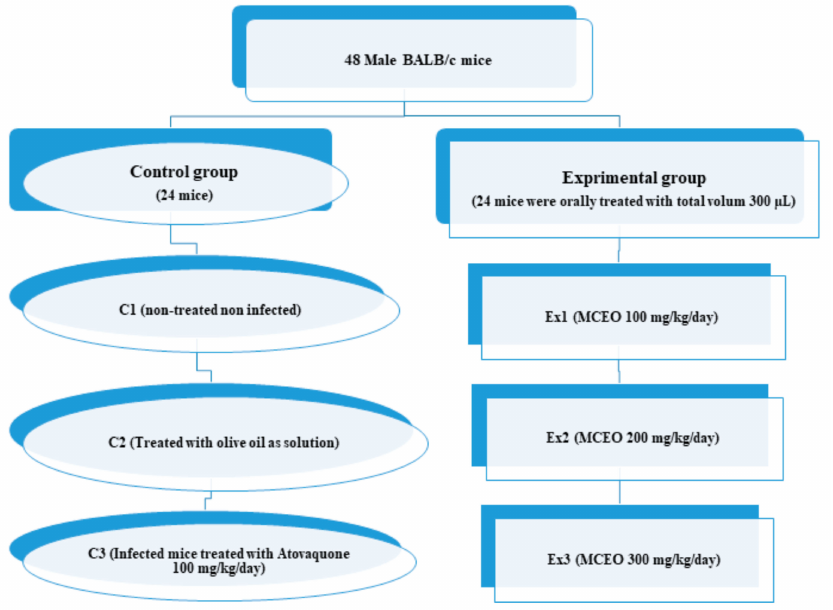
Figure 4. The flowchart of study design of the present